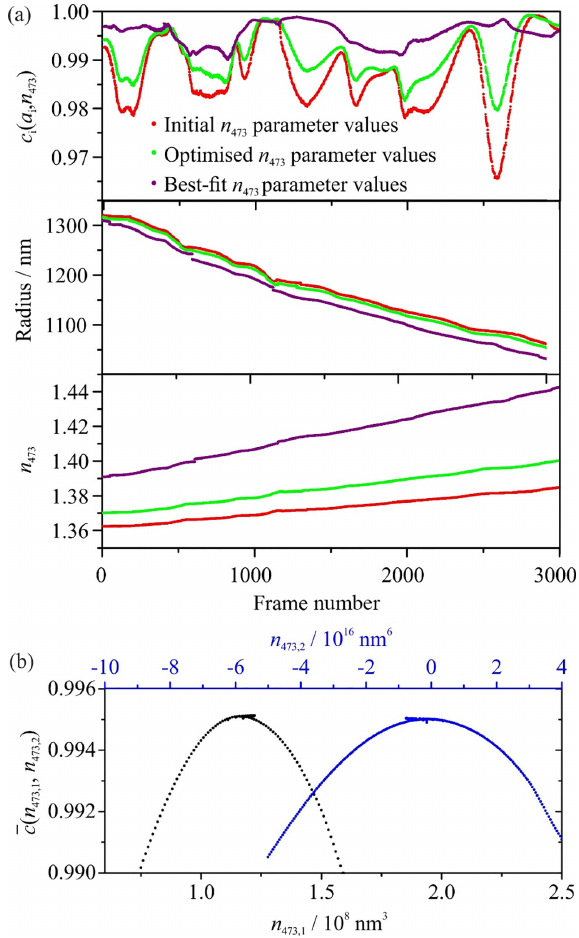
Figure 2. (a) The fitted radius, n 473 , and correlation coefficient variation with frame number for an aqueous NaNO 3 droplet. Red points correspond to initial n 473 parameter values, green points to further optimised values and purple points to the best-fit values. (b) The mean correlation coefficient, c(n 473 ) , and the parameters n 473 , 1 and n 473 , 2 were